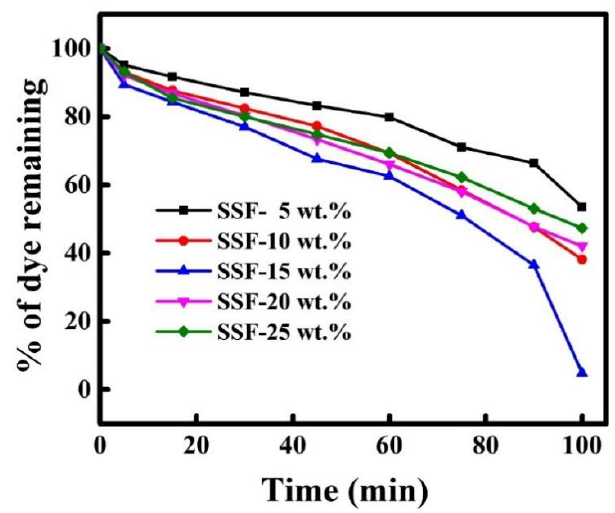
Figure 11. Catalytic activity of different SSF-wt % (SnS 2 -SiO 2 @α -Fe 2 O 3 ) nanocomposites on the photodegradation of MB.